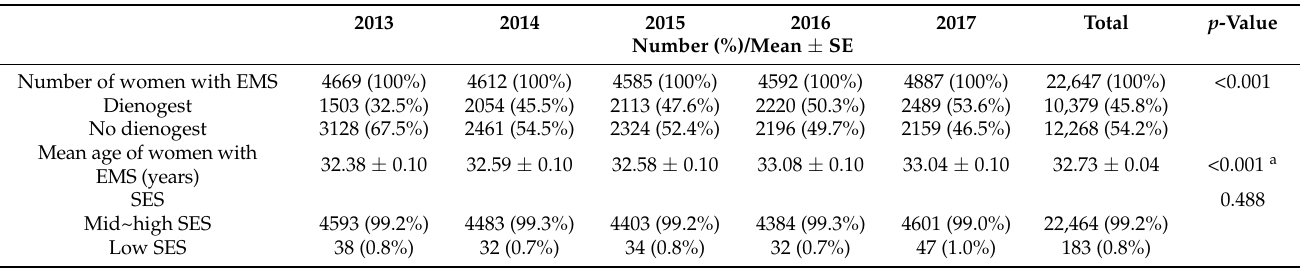
Table 1. Characteristics of the women with EMS injected with GnRH agonist according to the year in the HIRA 2013–2018 data.